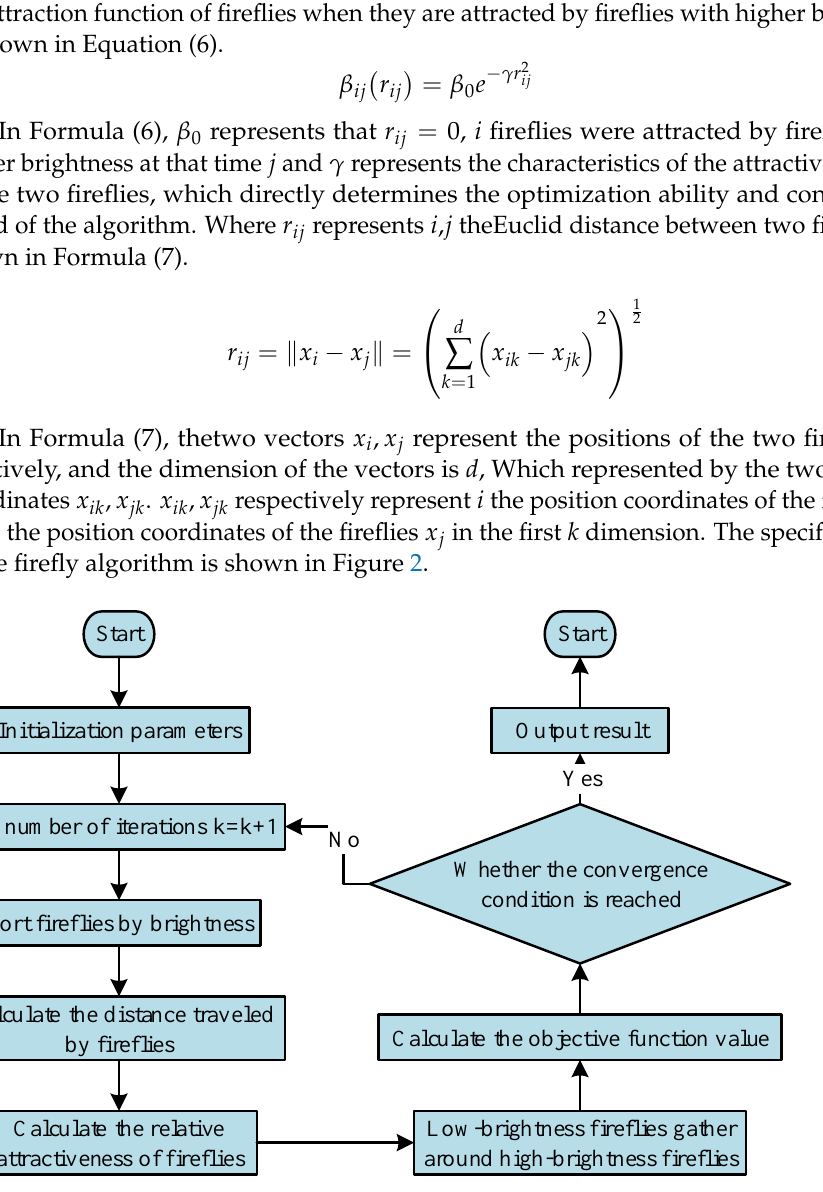
Figure 2. Basic flowchart of Firefly